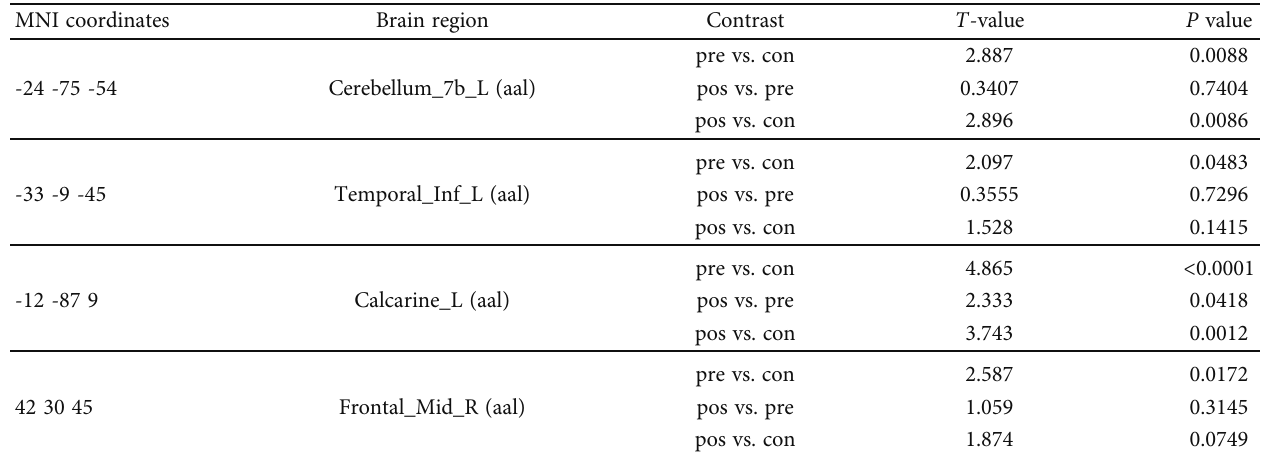
Table 5: The mfALFF values of these clusters were extracted for every participant and compared between each pair of the three groups in slow-5 band.